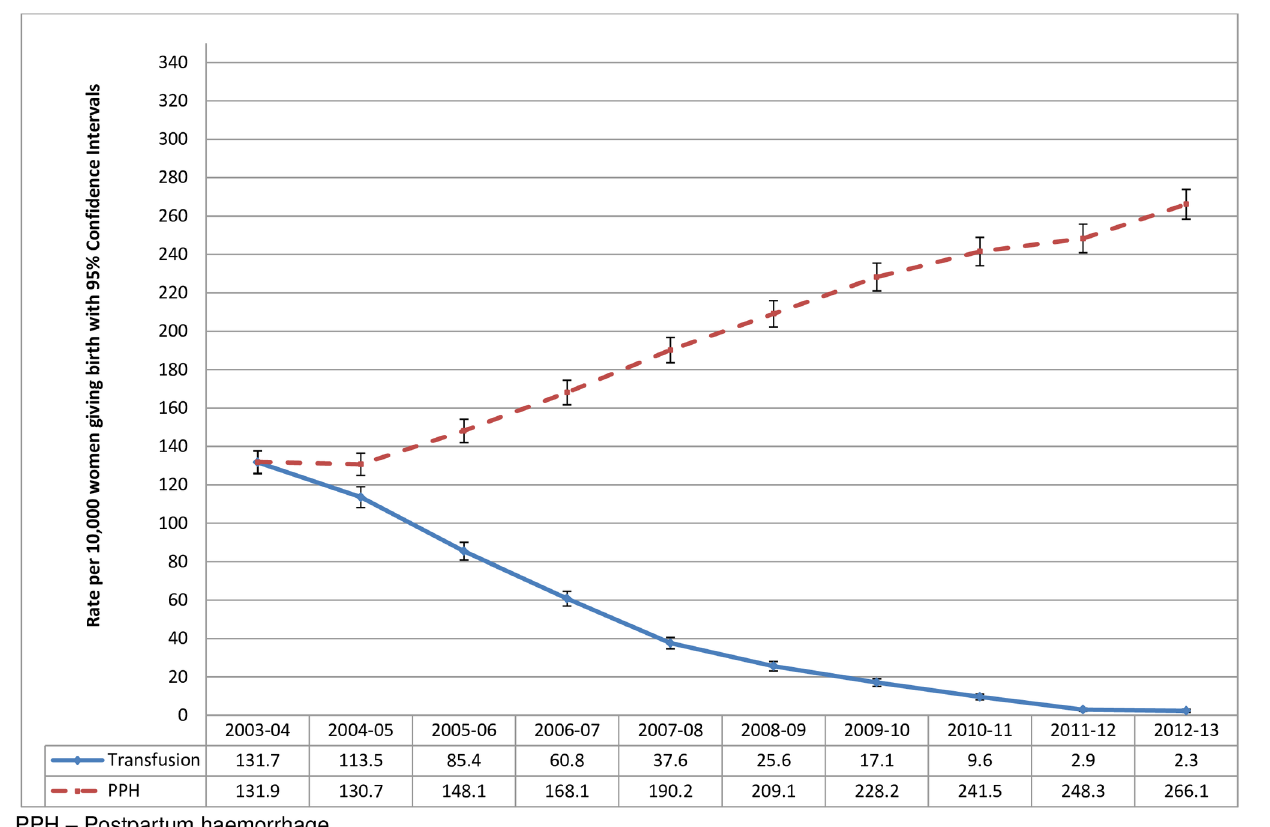
Fig 1. Comparison of the estimated rates of transfusion of blood and blood products and postpartum haemorrhage among women giving birth in England from 2003 to 2013; Hospital Episode Statistics data England.